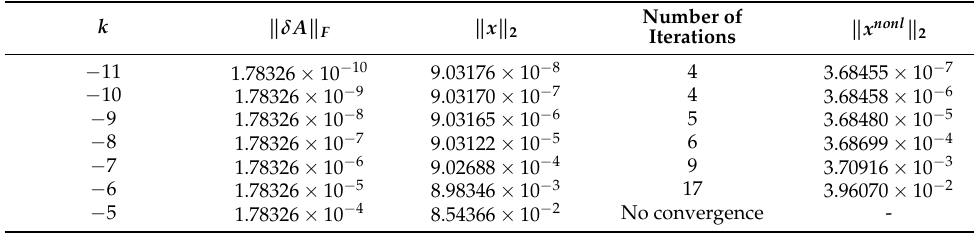
Table 9. Convergence of the global